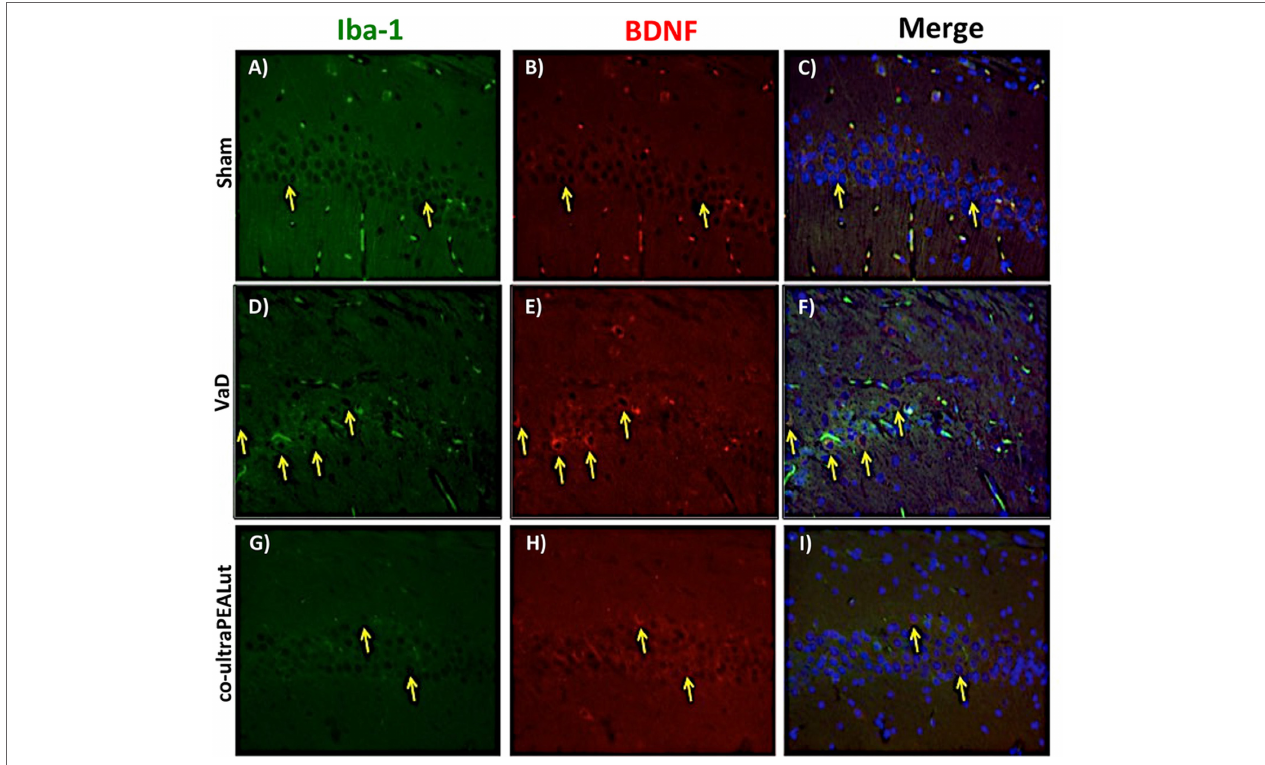
FigUre 10 | co-localization of iba-1/brain-derived neurotrophic factor (BDnF) after carotid arteries occlusion . Results are shown for Sham group (a–c) , mice after carotid arteries occlusion (D–F) , mice treated with co-ultraPEALut (g–i) . Brain sections were double stained with antibodies against Iba-1 [ (a,D,g) , green] and BDNF [ (B,e,h) , red]. Hippocampal area revealed increased microgliosis (D) in VaD group. Iba-1 immunoreactivity was reduced in co-ultraPEALut-treated mice (g) . Yellow spots indicate co-localizations and revealed a high co-localization between Iba-1/BDNF double staining (c,F,i) . The pictures are demonstrative of at least three experiments executed on distinctive experimental days. Images are representative of all the animals in every group. All images were digitalized at a resolution of 8 bits into an array of 2,048 × 2,048